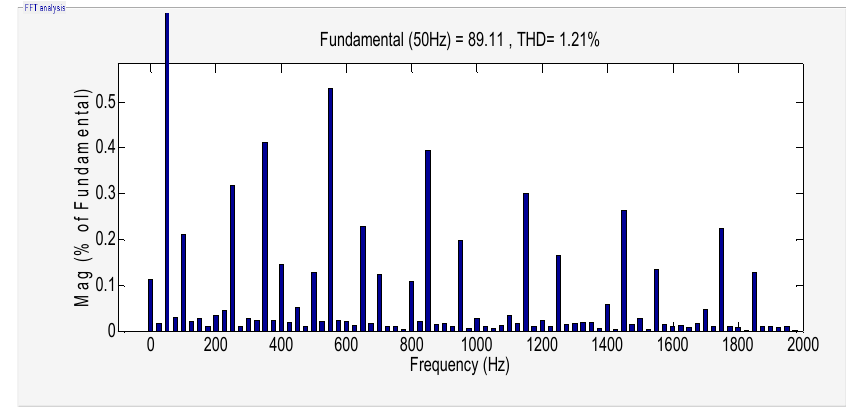
Figure 10. Harmonic spectrum of the source current at 0.16 s.